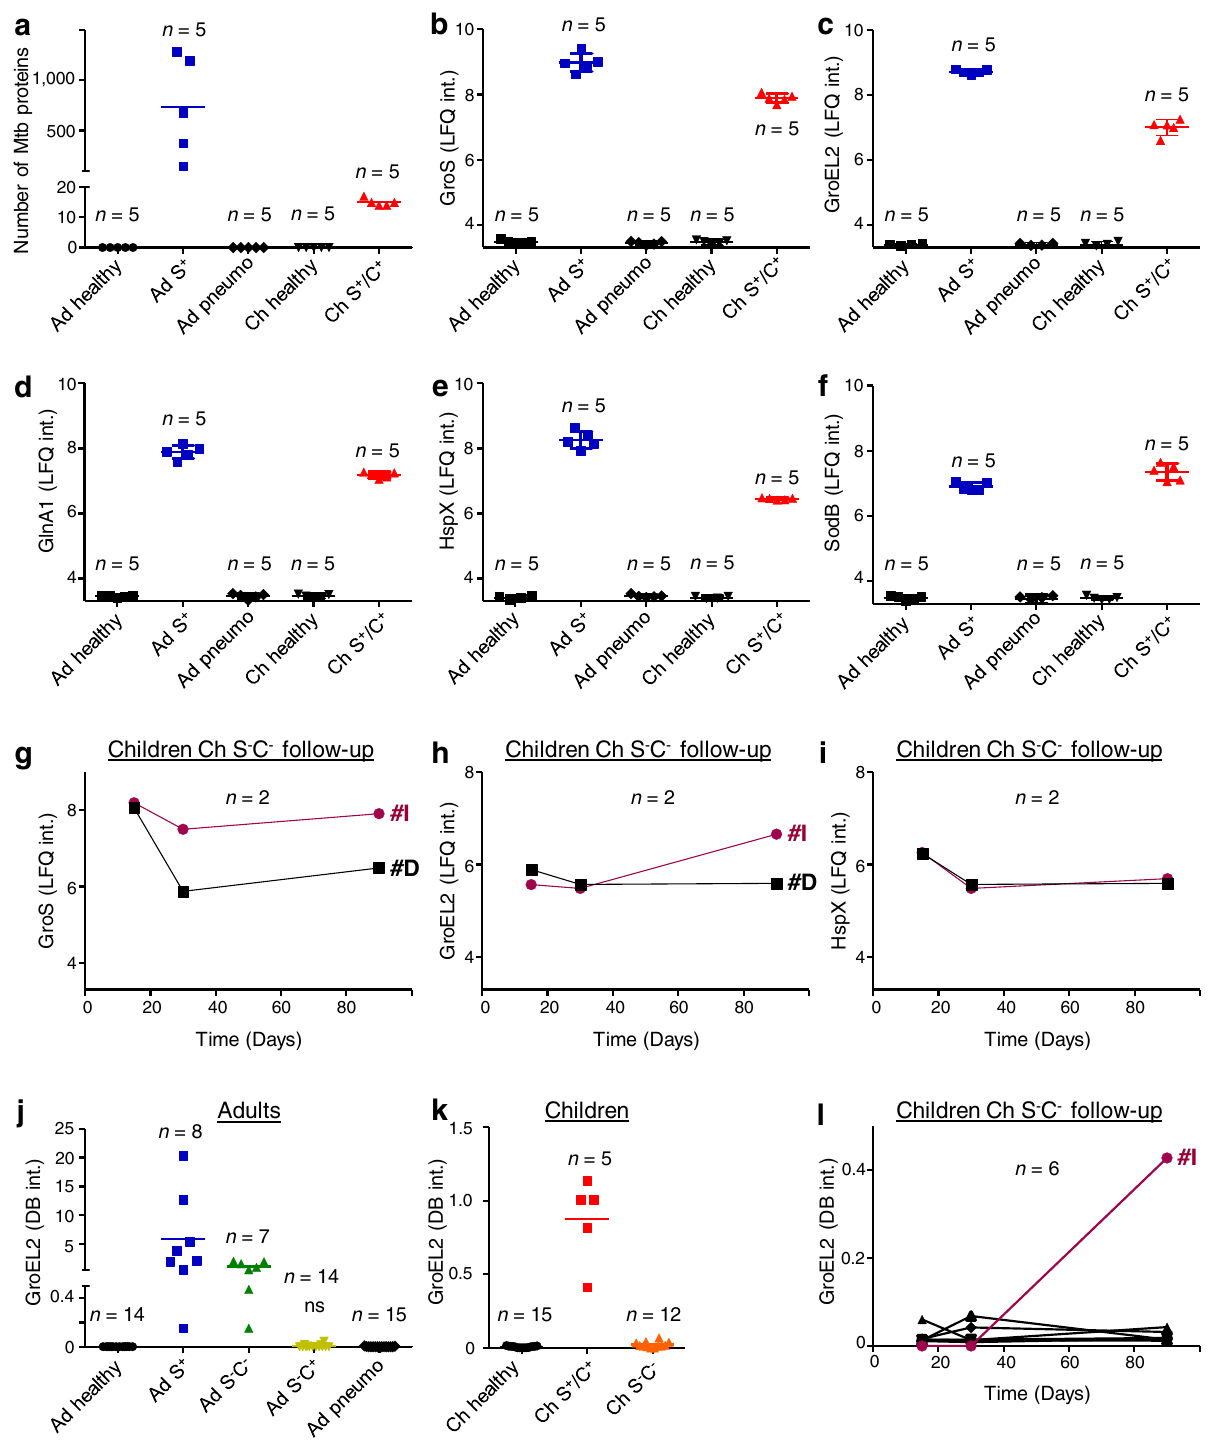
Fig. 5 | Abundance of M. tuberculosis proteins in EBC from TB patients and control individuals listed in Table 1. a Number of Mtb proteins detected by proteomic analysis in the corresponding groups. b – i Abundance of selected Mtb proteins by proteomic analysis. j – l Abundance of GroEL2 protein by an immu- noassay. In b – i , values are given as the Label-Free Quanti fi cation (LFQ) intensity (int.). The noise background intensity was ~3.3log. In j – l , values are given in